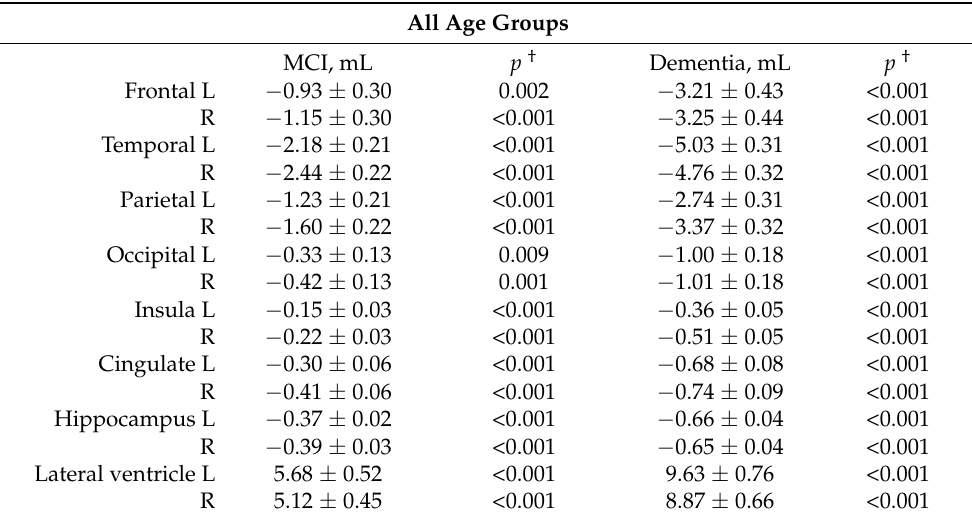
Table 2. Adjusted mean atrophy in regional brain volume for mild cognitive impairment (MCI) and dementia when compared to the cognitive normal reference